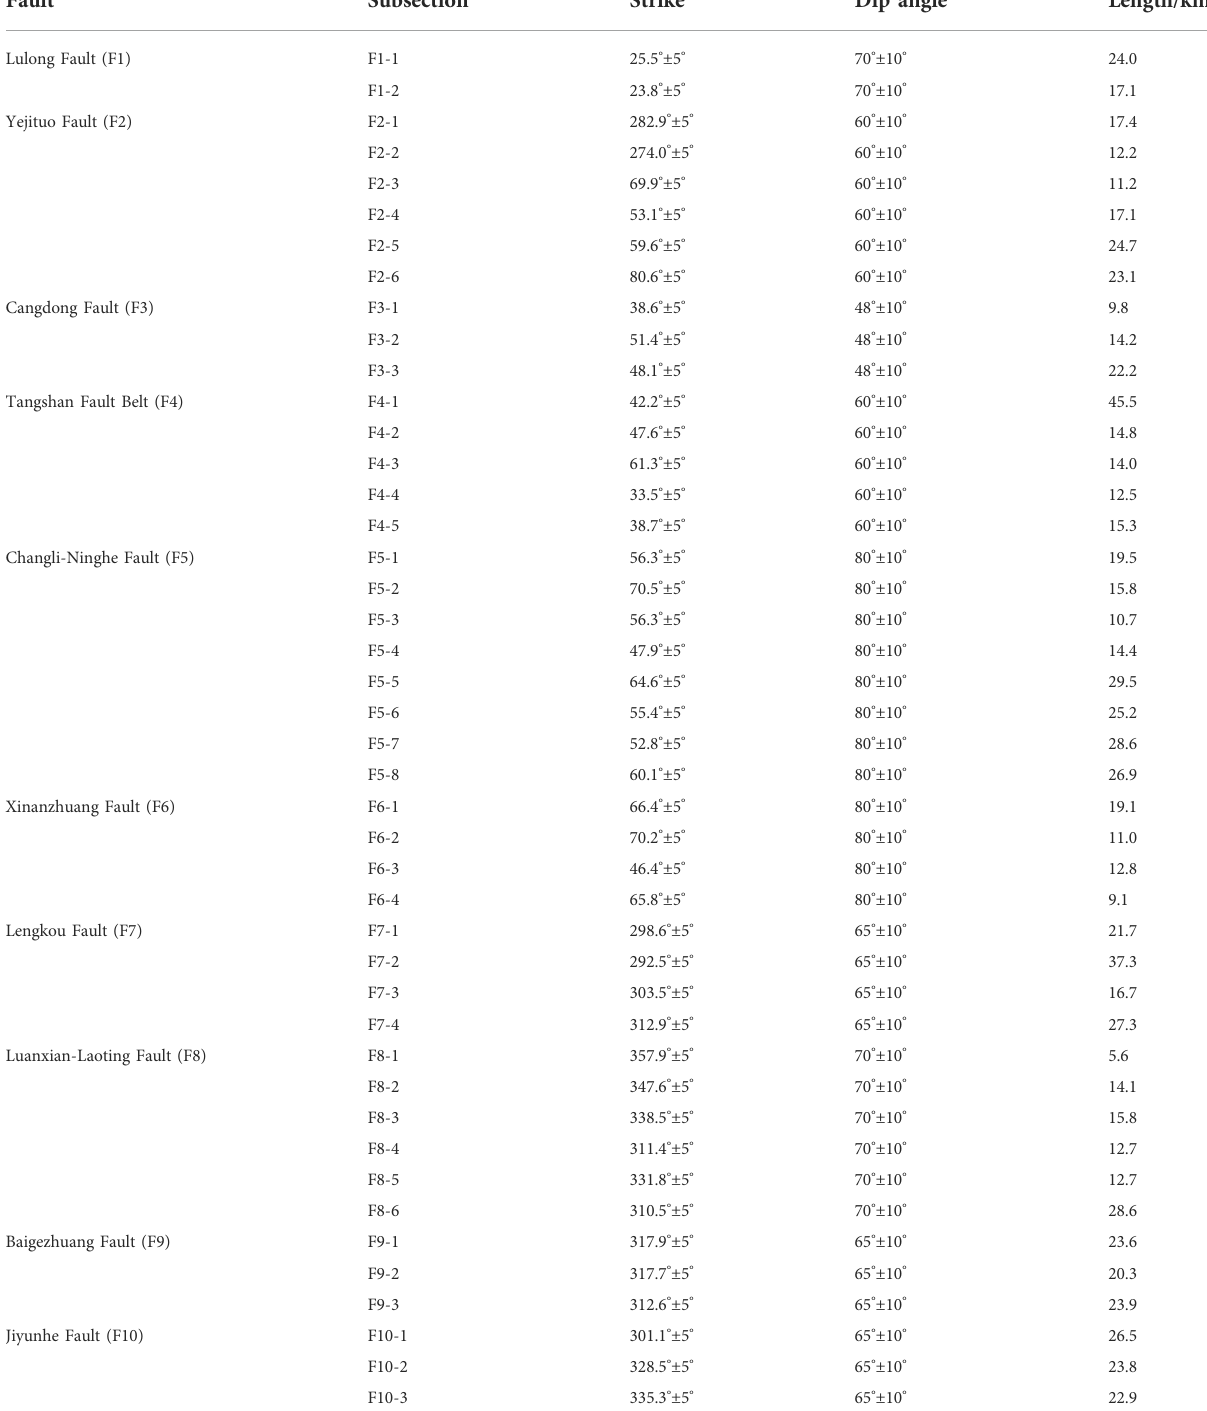
TABLE 3 Characteristic parameters of the main active faults in Tangshan seismic